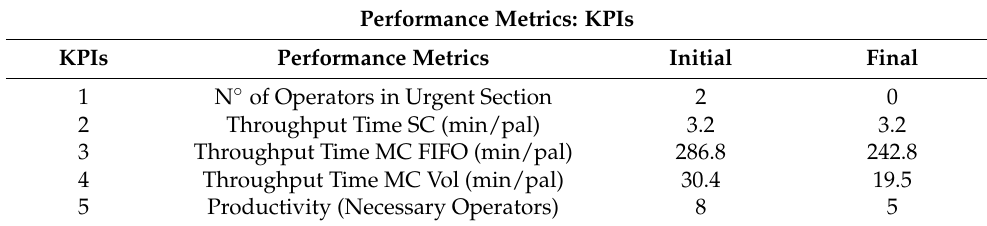
Table 12. Performance Metrics KPIs, initial values vs. final